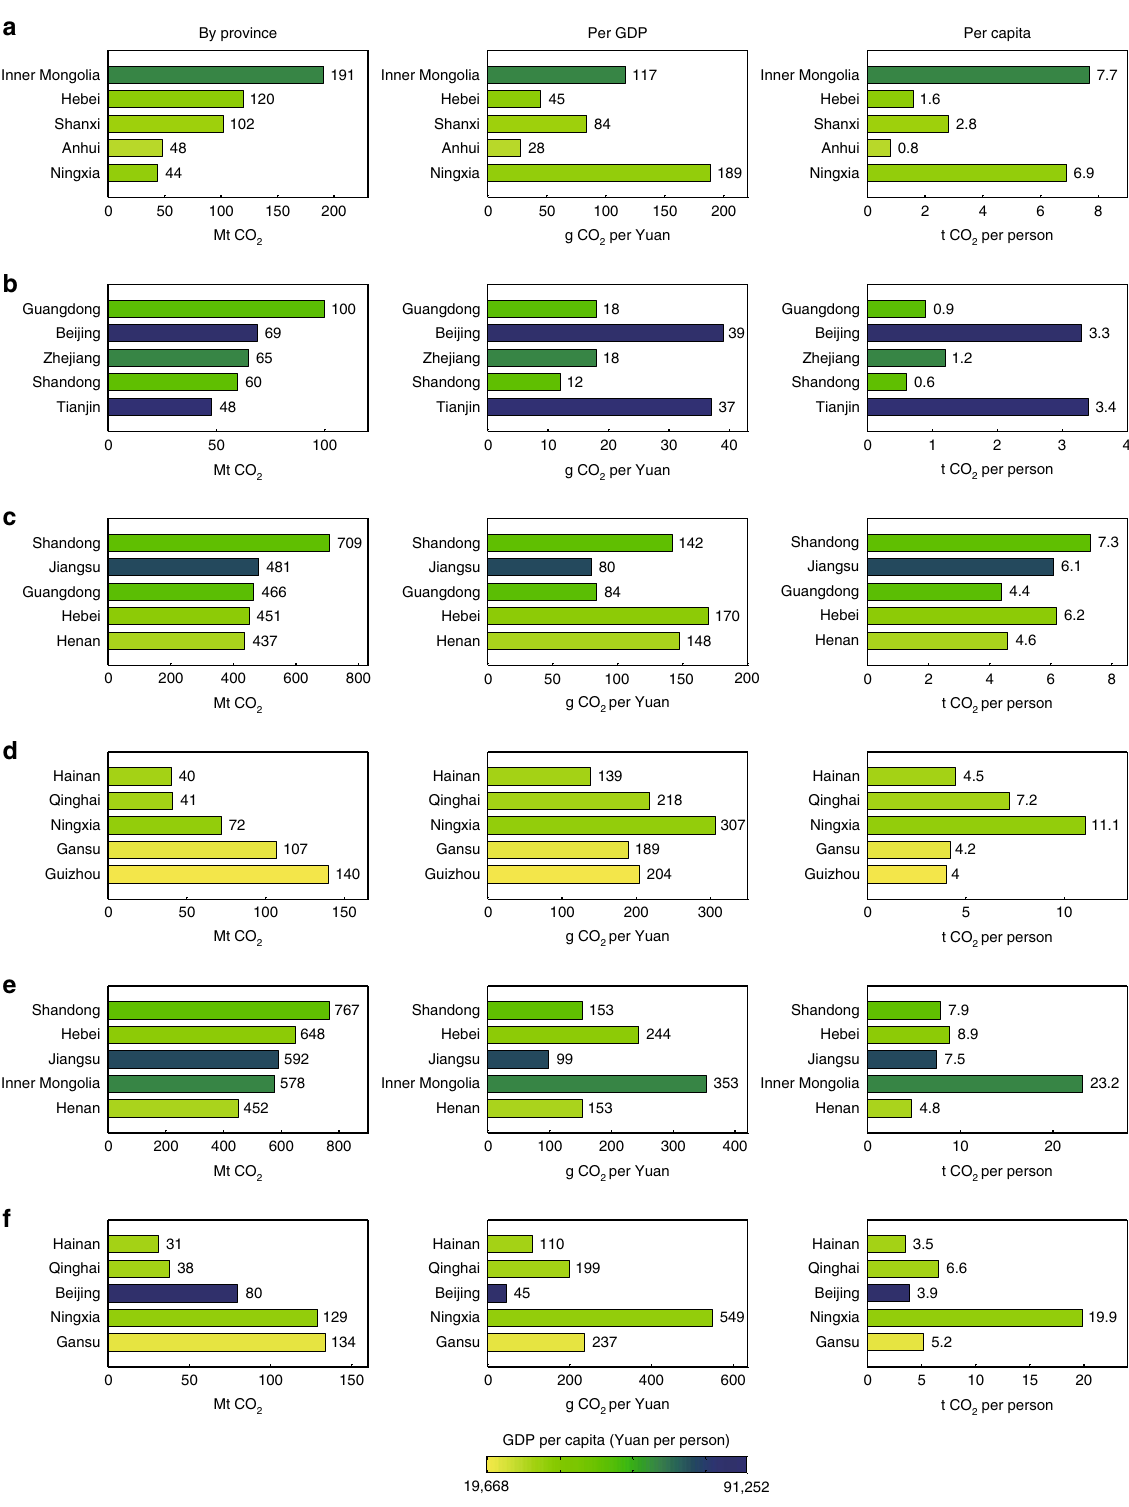
Fig. 1 Comparisons of emissions and fl ows at provincial level in China in 2012. a Top 5 net domestic emission out fl ows, b Top 5 net domestic emission in fl ows, c Top 5 consumption emissions, d Bottom 5 consumption emissions, e Top 5 territory emissions and f Bottom 5 territory emissions. The colours of bars correspond to provincial gross domestic product (GDP) per capita, from the most af fl uent provinces in red to the least developed provinces in green (see the scale). Mt means million tonnes, g means gram, t means tonne and CO 2 means carbon dioxide. See Supplementary Table 1 for territory-based and consumption-based CO 2 emissions for China ’ s 30